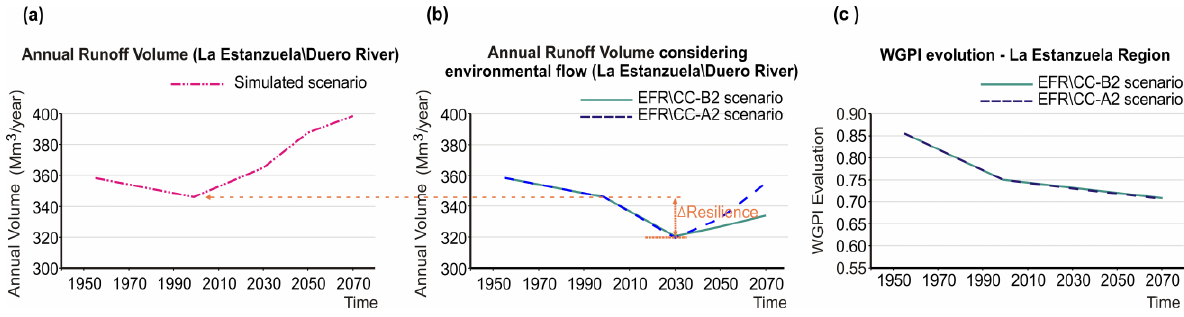
Figure 10. ( a ) The behavior of the runoff volume of the simulation scenario; ( b ) the behavior of the runoff volume under the environmental requirement and climate change scenarios, as well as a resilience limit; ( c ) the historical evaluation of the WGPI in the climate scenarios. Source: own elaboration.